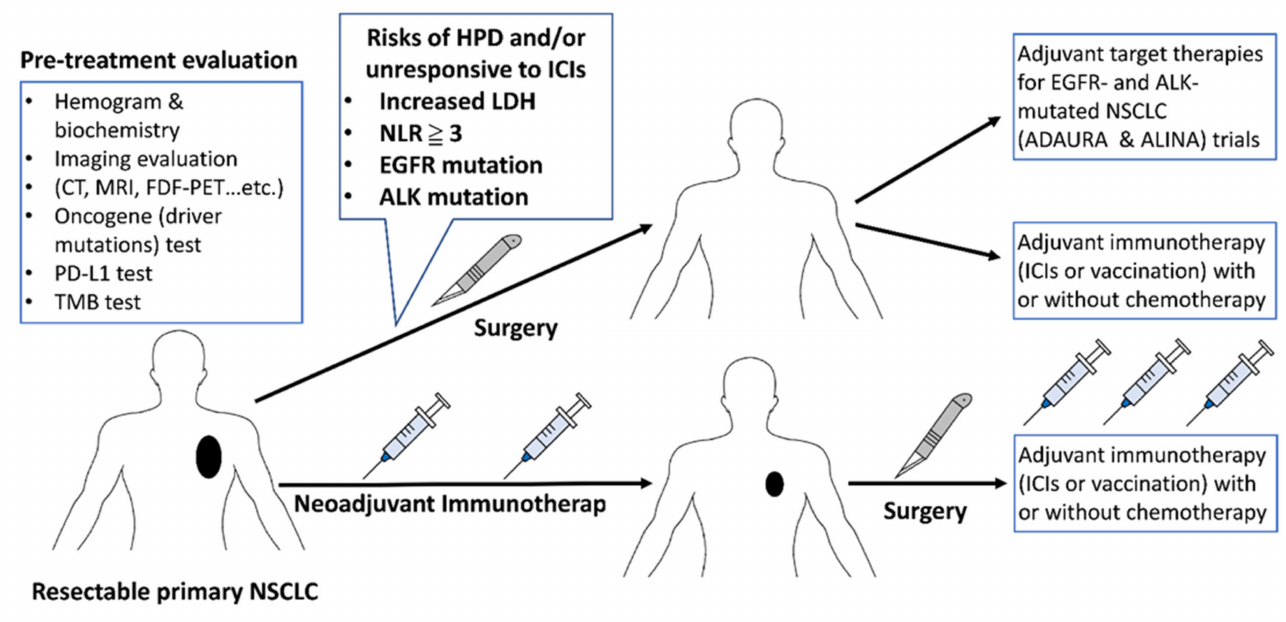
Figure 2. To optimize the strategy of pretreatment evaluation, neoadjuvant therapy, surgery, and adjuvant therapy are for early-stage NSCLC. Abbreviations: CT, Computed Tomography; MRI, Magnetic Resonance Imaging; FDG-PET, fluorodeoxyglucose-positron emission tomography; PD-L1, programmed Death-Ligand 1; TMB, tumor mutation burden; HPD, hyperprogressive disease; LDH, lactate dehydrogenase; NLR, neutrophil-to-lymphocyte ratio; EGFR, epidermal growth factor receptor; ALK, anaplastic lymphoma kinase; NSCLC, non-small cell lung cancer; ICIs, immune checkpoint